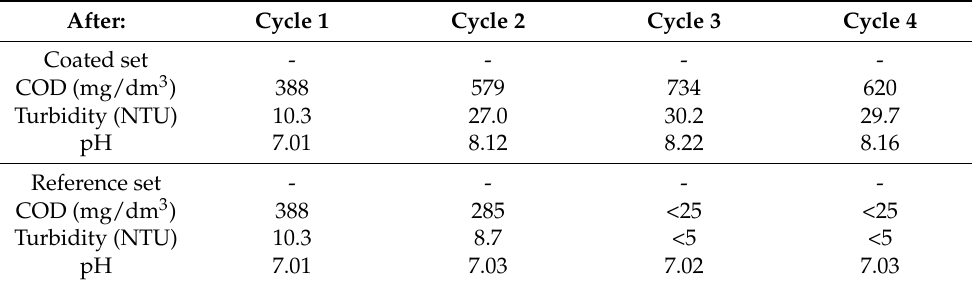
Table 3. Process water analysis after each